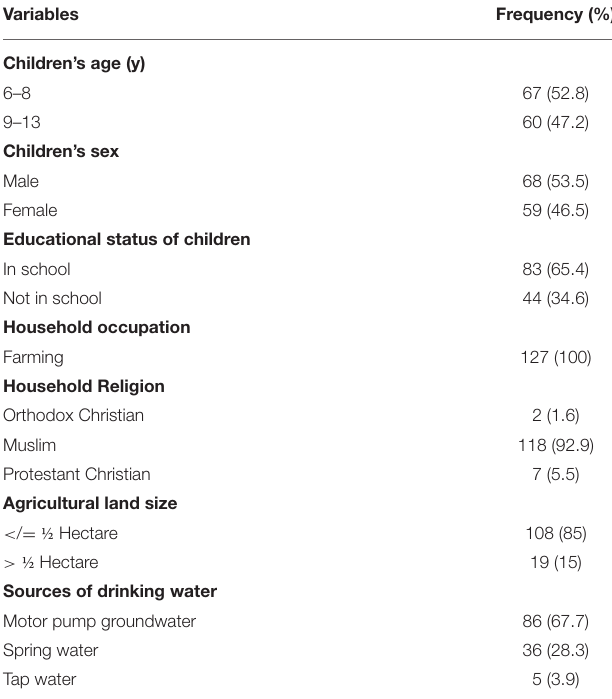
TABLE 1 | Socio-demographic characteristics of school-age children ( n = 127) aged 6–13 years from selected one kebeles, Halaba zone, SNNPR Ethiopia, 2019.